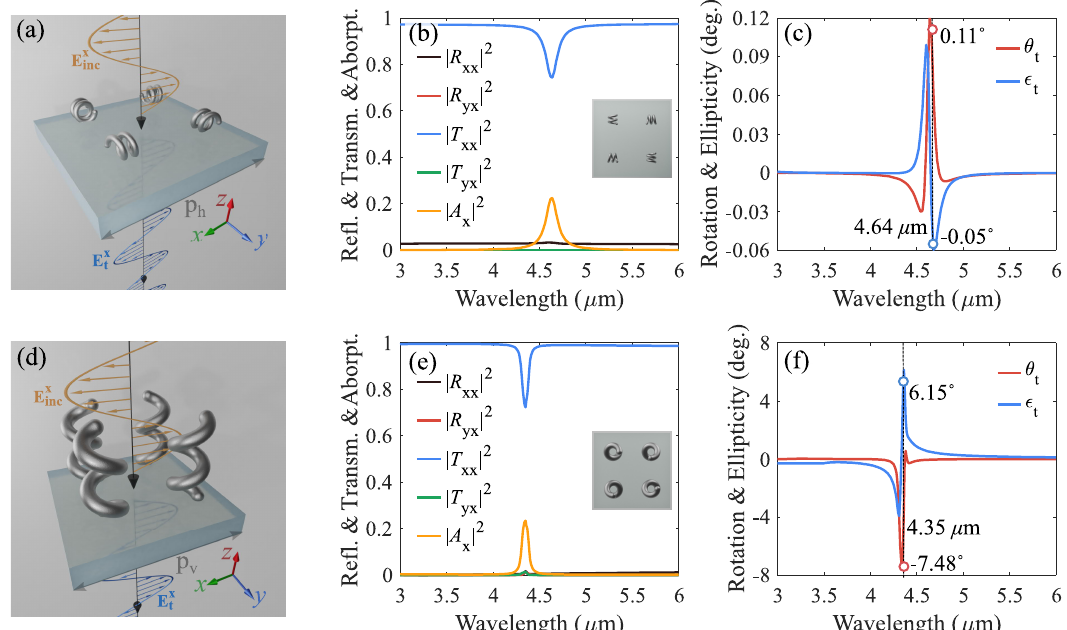
Figure 7. ( a ) The unit cell with horizontally-oriented double-turn helices with the lattice period of p h = 1.8 µ m for copolarized transmission regime. ( b ) Reflectance, transmittance, and absorbance spectra with the top view of the unit cell in the inset. ( c ) The polarization rotation angle and ellipticity of transmitted waves. ( d ) The unit cell of a metasurface consists of vertically oriented helices with a lattice period of p v = 2 µ m. ( e ) Reflectance, transmittance, and absorbance with the top view of the unit cell in the inset. ( f ) The rotation and ellipticity wavelength dependence of the metasurface based on vertically-oriented